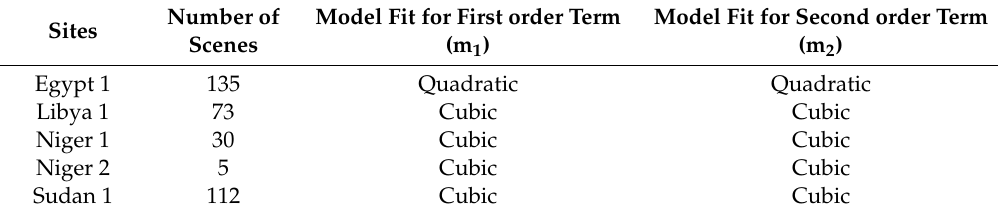
Figure 6. Quadratic model fit on quadratic coefficient as a function of wavelength for Egypt 1. Table 3. Summary of line fit for calculated slope of first order and second term as a function of wavelength for five PICS.